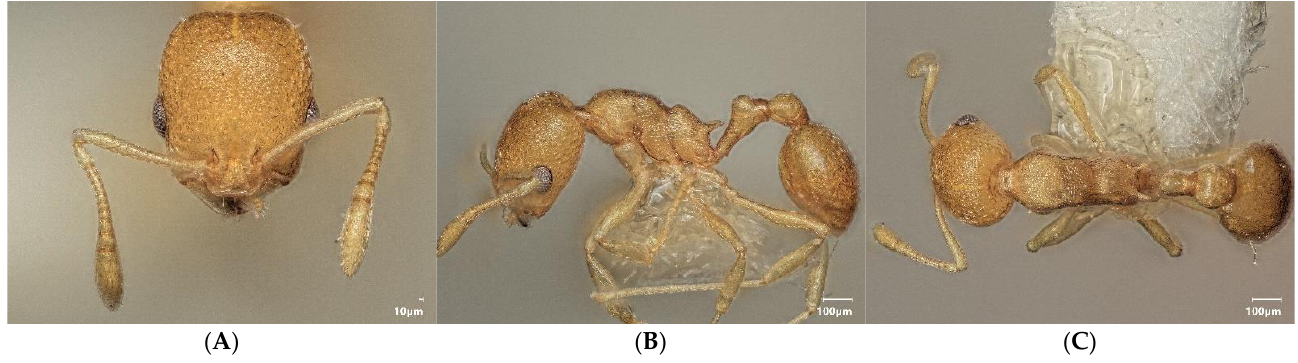
Figure 25. Cardiocondyla sulcata n.sp., paratype: head in dorsal view ( A ), lateral view ( B ), dorsal view ( C ). (85).